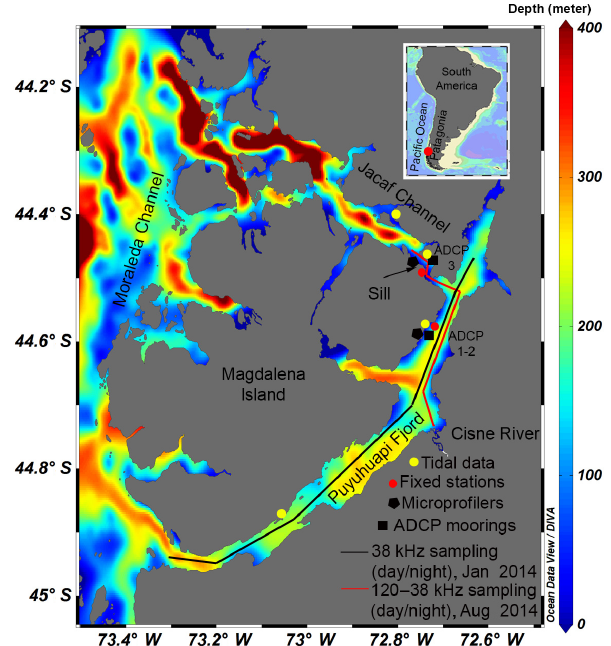
Figure 1. Study area in relation to South America and the Pacific Ocean shown in the inset. The main figure enlarges the study area (Puyuhuapi Fjord and Jacaf Channel) and indicates the instruments used for data collection, fixed point station positions and the sill location near the head of Jacaf Channel. The contours indicate the depth of the